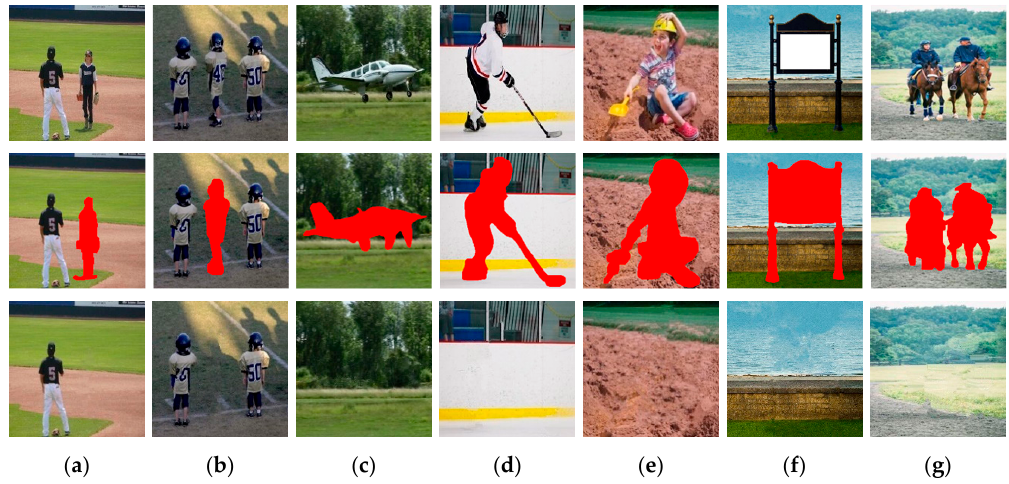
Figure 15. Examples of object removal using our method. Top row—original images; middle row—masks for the unwanted part; bottom row—results for object removal.